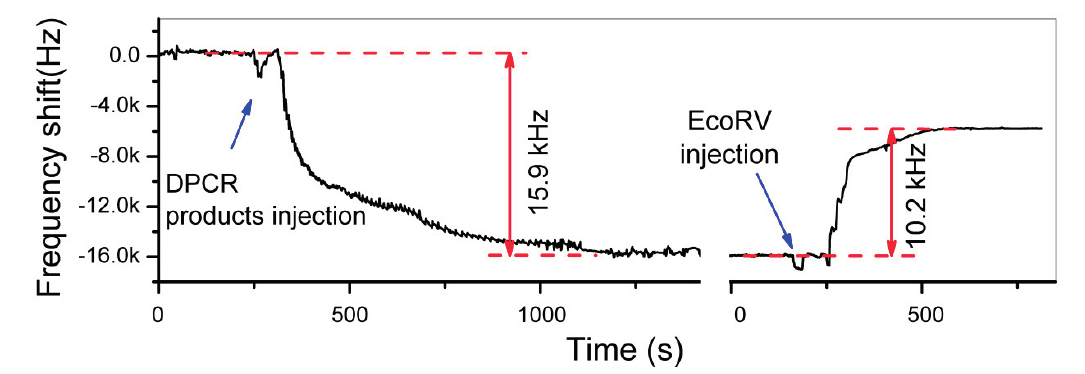
Figure 17. Results for experimental identification of double-strand DNA of E. coli O157:H7 and three control experiments. After the PCR products of E. coli O157:H7 (stx2F/Bio-stx2R) is injected into the detection chamber, the cantilever resonance frequency continually decreases that indicates the mass addition due to the binding of the biotinylated DNA onto the mesoporous-silica surface. After the enzyme is injected, the frequency reversely increases to reflect the enzyme digestion induced mass loss in real-time. Reprinted with permission from